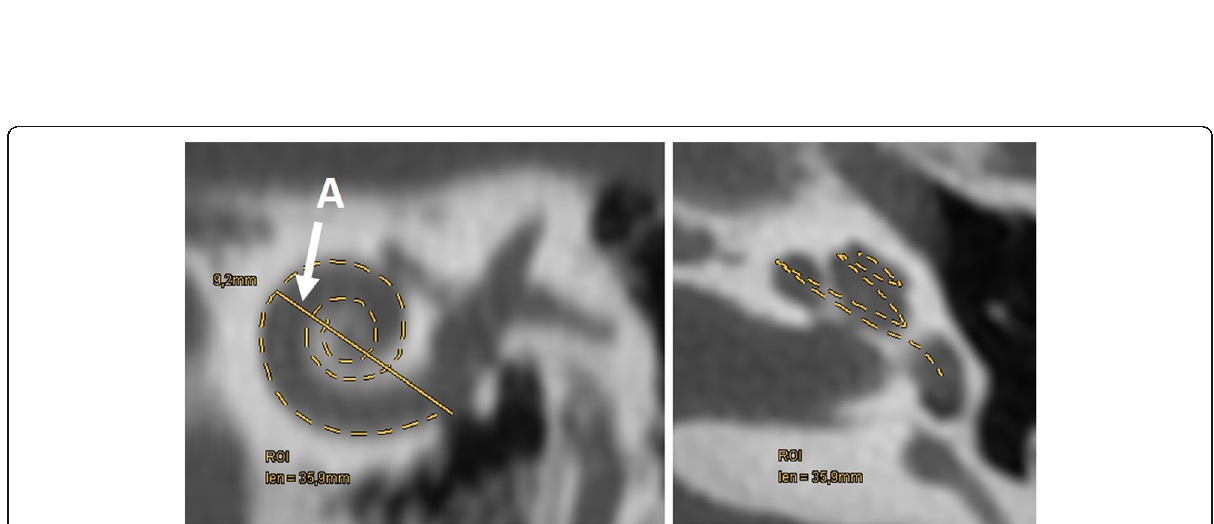
Fig. 2 Evaluation of cochlear duct length (CDL) using the formula CDL = 4.16A – 2.7 and a 3D segmentation (dashed line). HRCT paracoronal image on the left shows distance A (arrow) from the center of the round window to the far most extension of the basal turn, which measures 9.2 mm. According to the formula the cochlea duct has a length of 35.6 mm. The dashed line in the HRCT paracoronal image and the HRCT paraaxial image on the right shows the 3D segmented cochlear duct which measures 35.9 mm